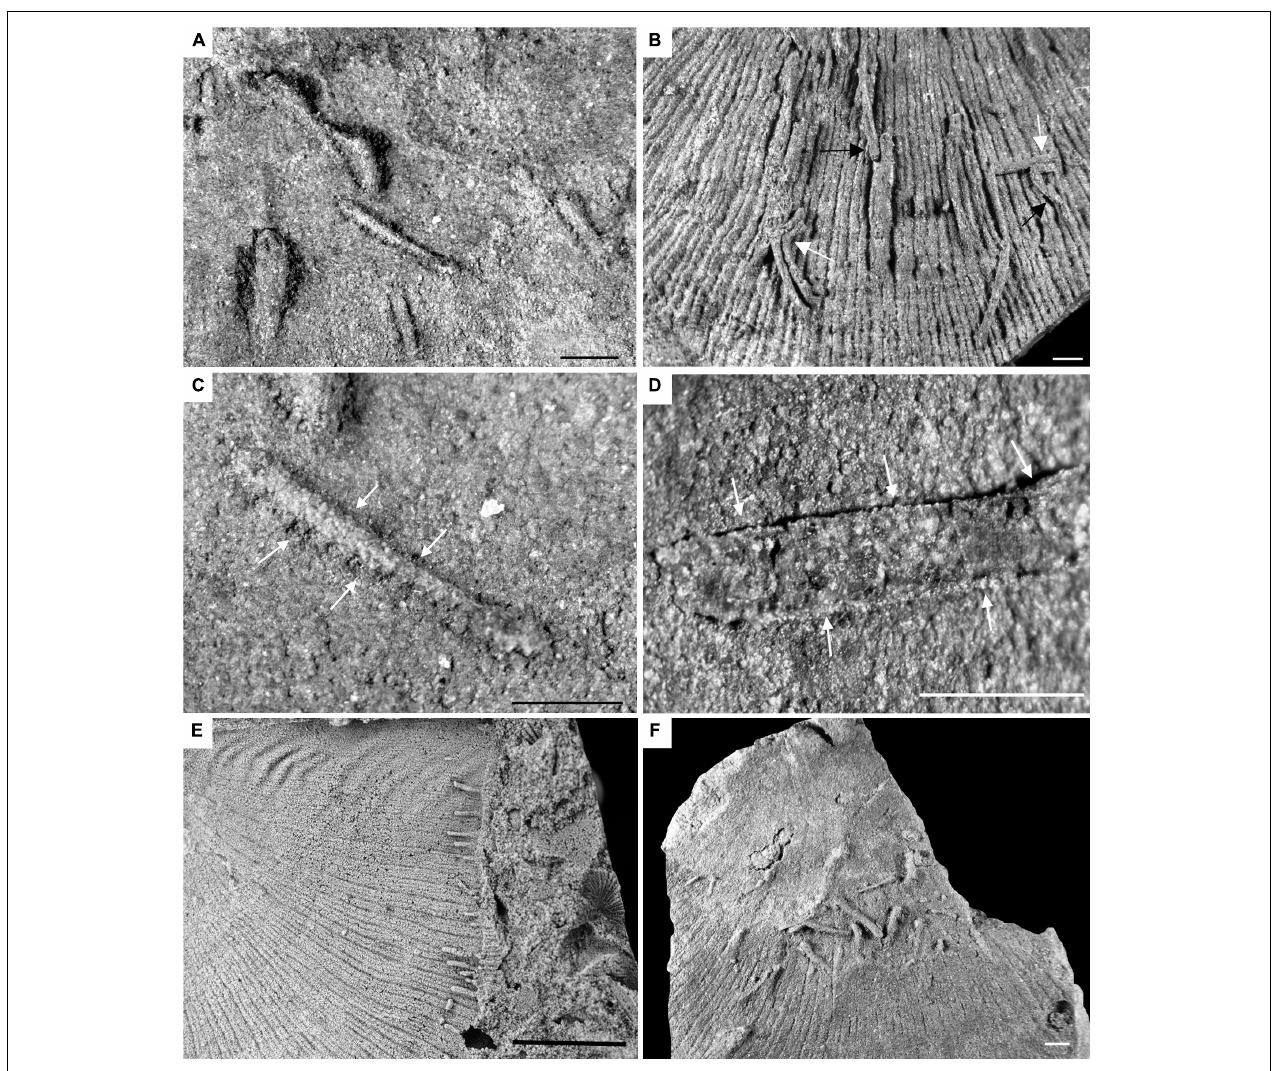
FIGURE 1 | Valves of Colaptomena expansa with Palaeosabella prisca borings. (A–C) External moulds of ventral valves. (A) Showing a rounded and clavate terminus (CPI-1001). (B) Borings closely crowded touching and bending their trajectory (white arrows) or overlapping slightly (black arrow) (CPI-10002). (C) Specimen showing the filling with a rough transverse segmentation and remains of the lining (white arrows) (CPI-10001). (D) Close-up view of a tube lined with some silt-sized sediment grains (white arrows). Internal mould of ventral valve (CPI-6506). (E) Borings arranged parallel to the radial ornamentation and oriented toward the umbo. External mould of ventral valve (CPI-6504a). (F) Borings randomly arranged (CPI-10003). All scale bars = 1